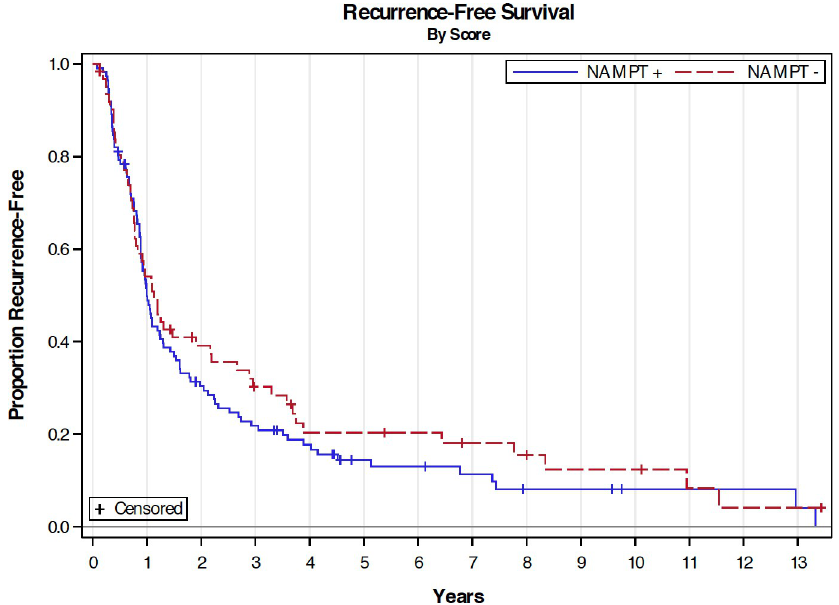
Fig 3. Recurrence-free survival by NAMPT IHC score. Kaplan-Meier curves showing recurrence-free survival of patients with NAMPT+ (blue line) and NAMPT- (red line) PDA. Median OS: 12.0 months (NAMPT+) vs. 13.5 months (NAMPT-); P -value: